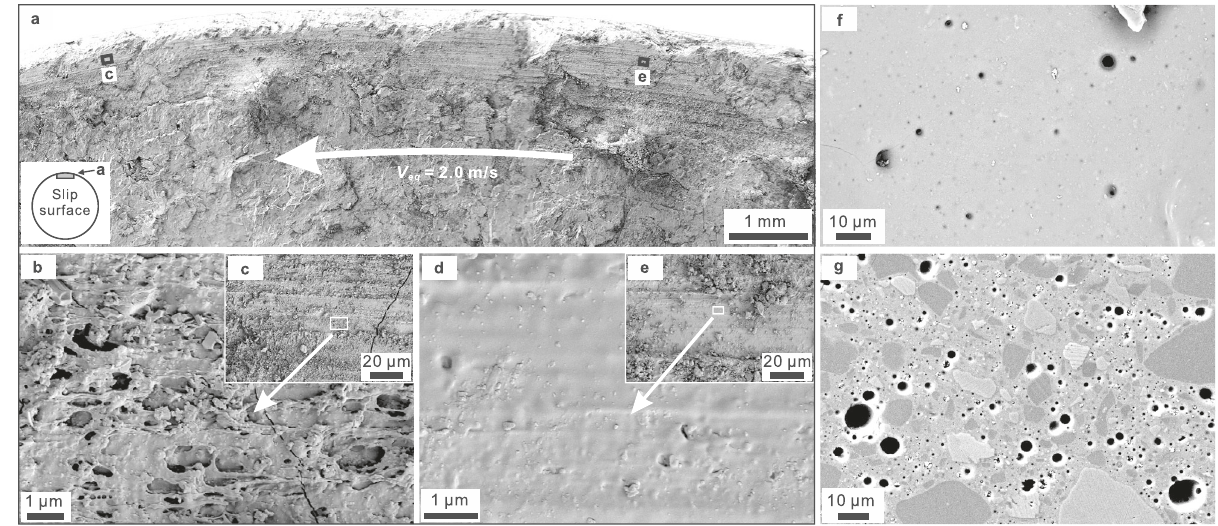
fl uid pressure rise in the slip zone. f , g Close-up images of the molten patches or layers developed in large-displacement (10 or 20m) experiments ( f : top view, LHV1058; g : thin-section, LHV968; see their overall textures in Supplementary Fig. S5b, c).